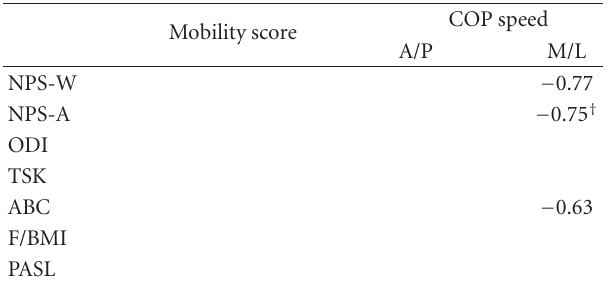
Table 4: Pearson correlation coe ffi cients and partial correlations with mobility scores and COP measures (eyes open condition) for the CLBP